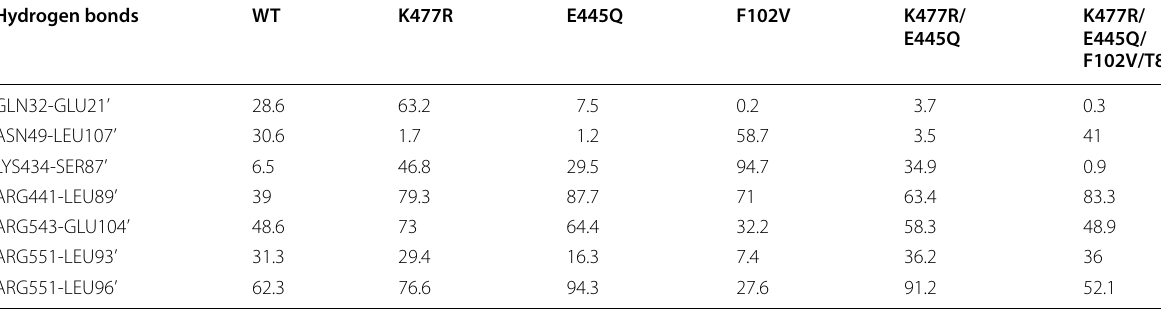
Table 4 Probability of hydrogen bonds formation at the decamer interface of the wild-type CadA and its mutants Hydrogen bonds WT K477R E445Q